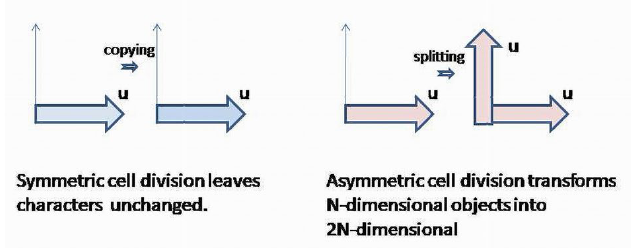
Figure 4. Symmetric and asymmetric cell